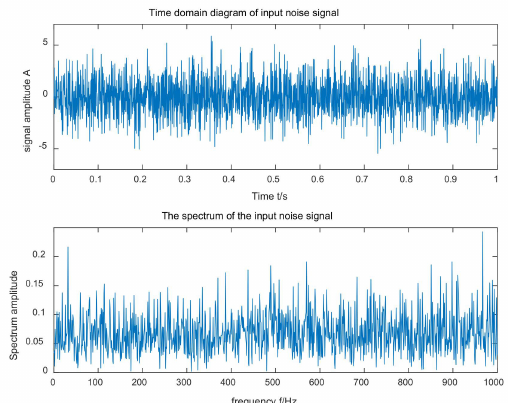
Figure 5. Input signal time domain waveform and FFT spectrum of the simulation model.